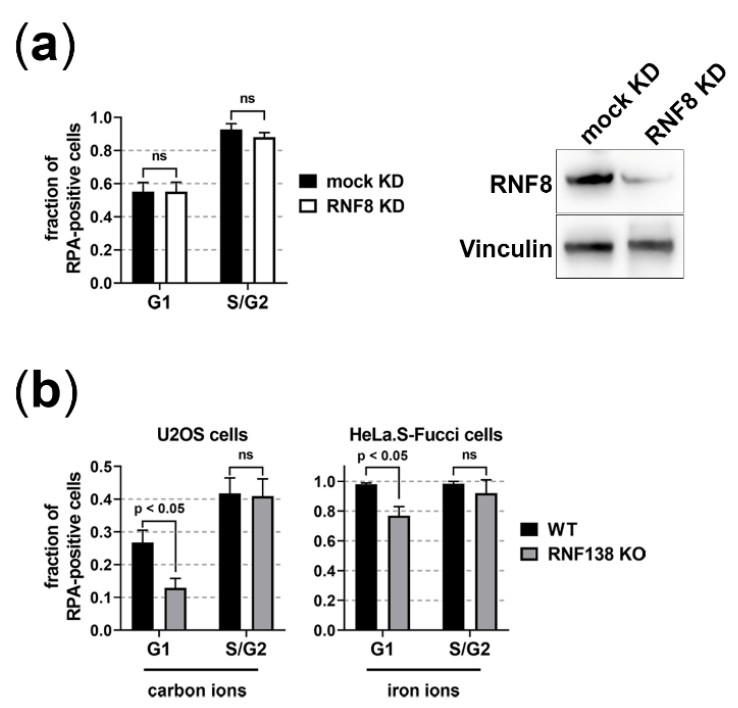
Figure 3. RNF138 is involved in resection of complex DSBs in G1-phase cells. To visualize resection, we fixed the cells 1 h after irradiation and immunostained the resection marker RPA. To allow cell-cycle specific analyses, we used the endogenous Fucci system in HeLa.S-Fucci cells. In NFFhTERT and U2OS cells, we immunofluorescence stained the cell-cycle marker CENP-F (CENP-F positive: S, G2, and M phase; CENP-F negative: G1 phase). DNA was stained with DAPI, to visualize the nuclei of all cells and to distinguish M-phase cells. At least 100 cells per condition were analyzed from at least 6 fields of view in order to average the number of RPA positive cells. n = 1, error = SEM for the different fields of view. Two-tailed Mann-Whitney test, p values < 0.05 were considered significant; ns, not significant. ( a ) NFFhTERT cells were depleted or mock depleted for RNF8 by RNAi. In addition to a western-blot analysis, the RNF8 depletion was verified by quantification of radiation-induced 53BP1 foci per nucleus (Supplementary Figure S2a,b) and irradiated with 2 Gy α -particles to induce complex DNA damage. Cells showing more than 5 RPA foci (i.e., RPA signal well above background) after irradiation were considered resection positive. The average number of RPA positive non-irradiated cells was subtracted. ( b ) U2OS or HeLa.S-Fucci cells RNF138 proficient or deficient (wt or RNF138 KO) were irradiated in a low angle (5 × 10 6 p./cm 2 ) with carbon ions (6.5 MeV/nucleon) or low-energy iron ions. Irradiated cells (i.e., cells showing γ H2AX streaks) positive for RPA-decorated ion traversals within their nuclei 1 h after irradiation were considered resection positive. The RNF138 deficiency caused by an RNF138 knockout (KO) was checked by western-blot analysis (supplemental Figure